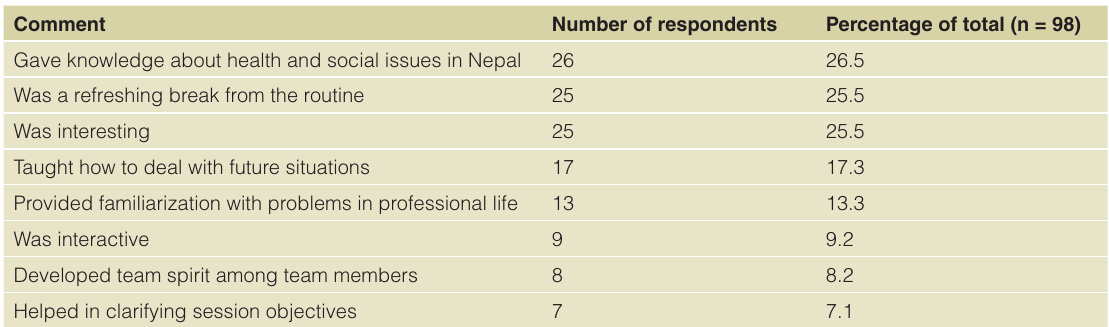
Table 2. Common overall comments about the medical humanities